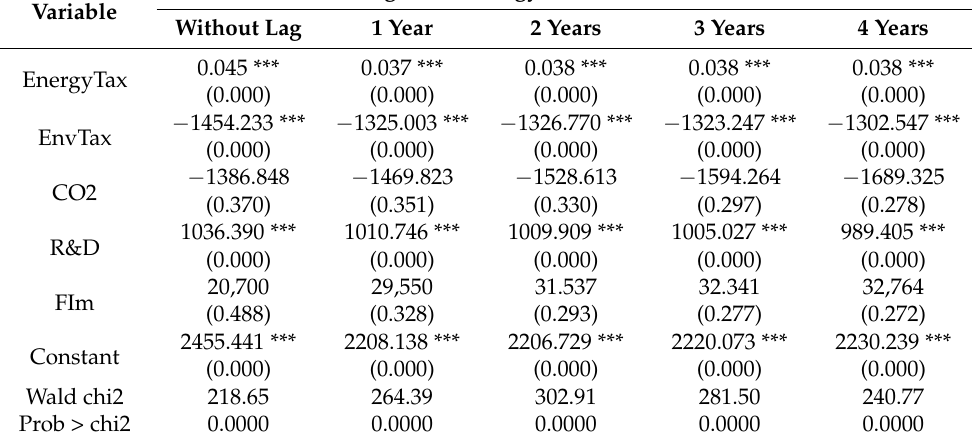
Table 3. Results of the assessment of energy taxes impact on the biofuel production in the European countries for